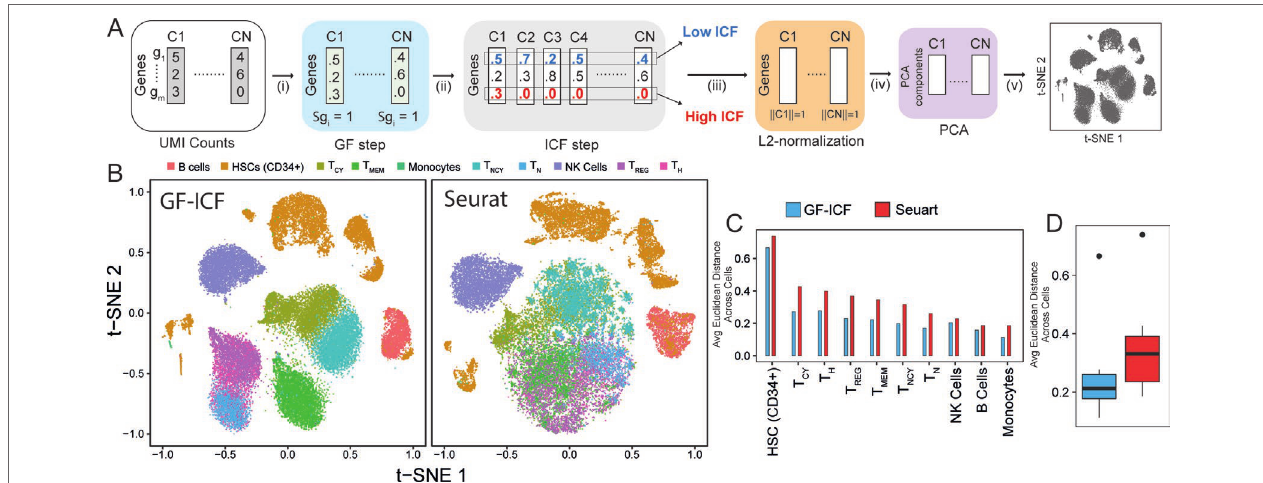
FIGURE 1 | GF-ICF improves visualization of single-cell RNA-sequencing data. (A) The gf-icf pipeline. Starting from transcriptional profiles of a set of cells C1…CN, the pipeline consists of the following steps: (i) normalization of gene expression profiles of each cell to sum one (GF step); (ii) cross-cell normalization, to score rarely expressed genes higher than commonly expressed genes (ICF step); (iii) L2 normalization on each cell to obtain normalized gf-icf weights; and (iv) principal component analysis (PCA) to reduce the number of features (genes) dimensions before (v) projecting cell in an embedded space. (B) Comparison between t-SNE projection following gf-icf pipeline (left) and the Seurat tool (right) on 40k human PBMCs single-cell transcriptional profiles. Cells are colored according to their cell type of origin identified by FACS analysis by Grace et al. (C) Average Euclidean distance among PBMCs of the same type using either gf-icf pipeline or the Seurat tool. (D) Distribution of the average Euclidean distance among PBMCs of the same type using either gf-icf pipeline or the Seurat tool. Legend: T CY , cytotoxic T-cells; T H , helper T-cells; T REG , regulatory T-cells; T MEM , memory T-cells; T NCY , naïve cytotoxic T-cells; T N , naïve T-cells; NK cells, natural killer